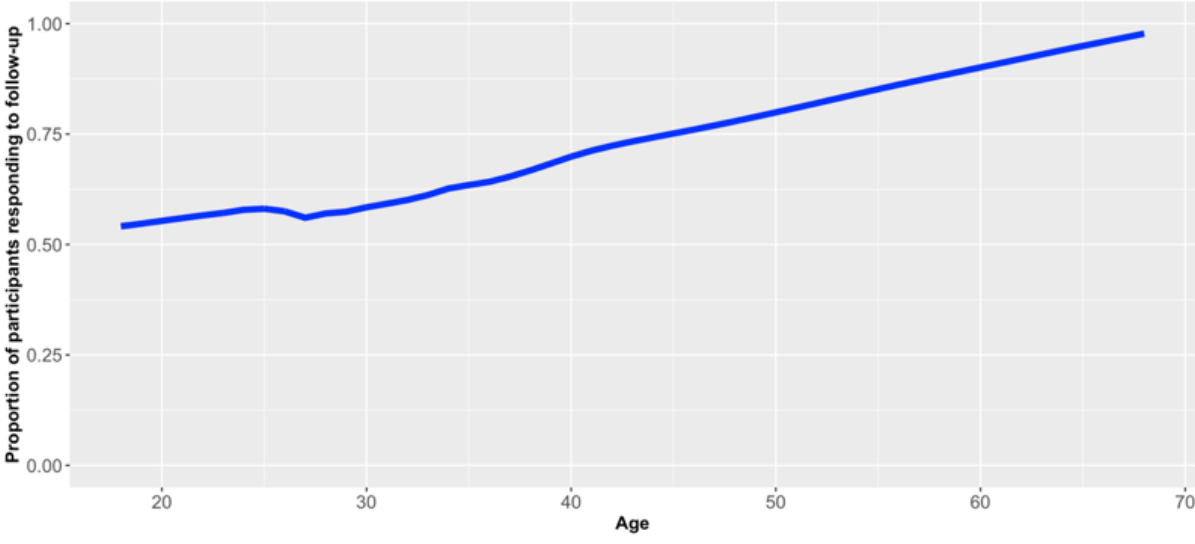
Figure 3. Locally weighted scatterplot smoothing: age against proportion of participants responding to follow-up for all participants.